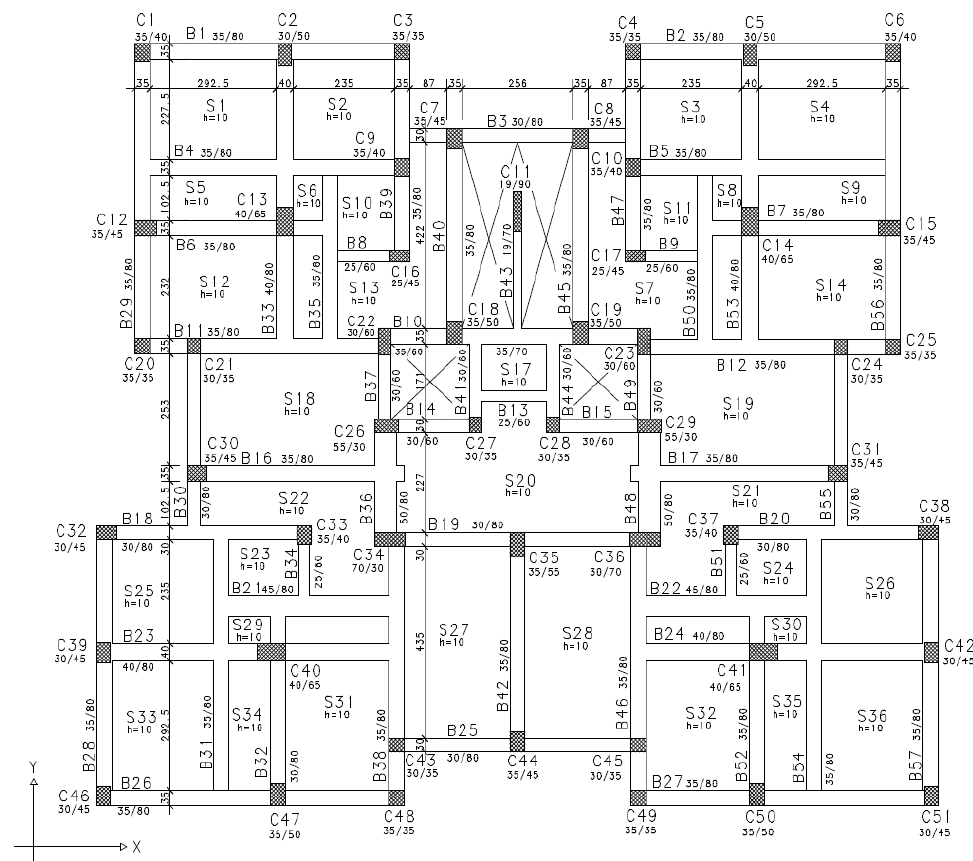
Figure 4. Formwork plan of the support concrete structure. Adapted: Medeiros [5]. Table 2. Variations adopted for the model